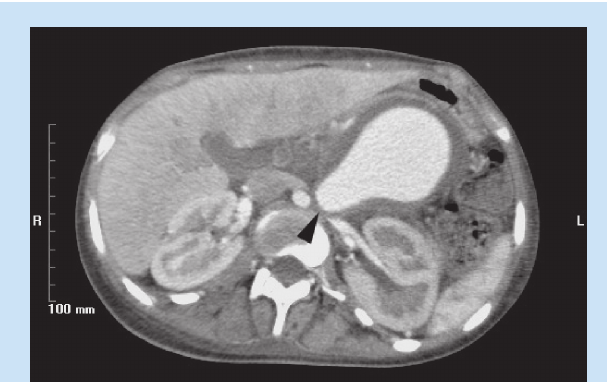
Fig. 2. CT angiogram indicating an aneurysmal superior mesenteric artery (arrowhead). The proximal segment of the abdominal aorta is of normal